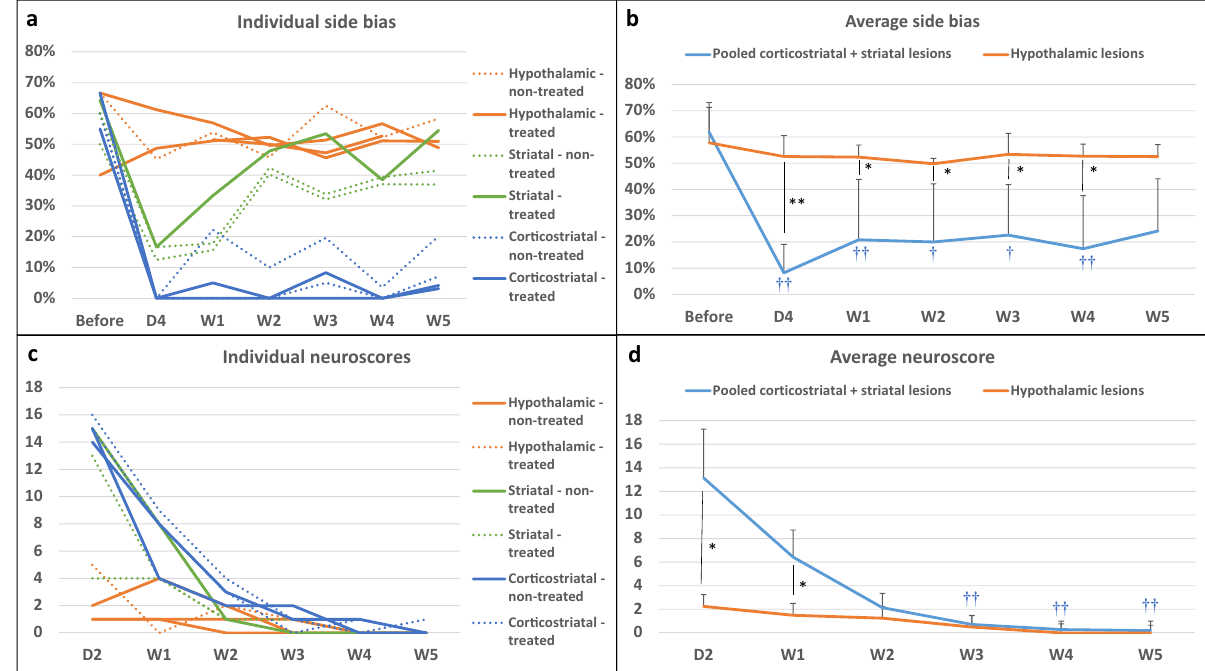
Figure 3. Neurofunctional readouts. ( a ) Individual side bias according to lesion subtype and treatment group (plain line: treated; dashed line: non-treated) in the first 5 weeks post-surgery. ( b ) Average side biases according to lesion subtype: pooled (corticostriatal + striatal) vs. hypothalamic lesions. ( c ) Individual neuroscores according to lesion subtype and treatment group (plain line: non-treated; dashed line: treated) in the first 5 weeks post-surgery. ( d ) Average neuroscores according to lesion subtype: pooled (corticostriatal + striatal) vs. hypothalamic lesions. Data are displayed as mean ± SD. W weeks, D days. *p < 0.05, **p < 0.01, (corticostriatal + striatal) vs. hypothalamic, Wilcoxon–Mann–Whitney test; † p < 0.05, †† p < 0.01, D4 to W5 vs. before, Friedman